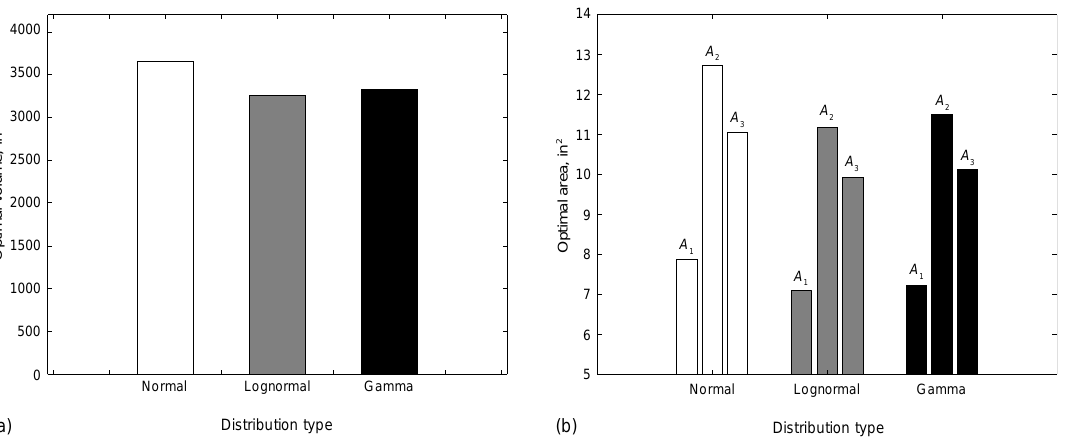
Figure 6. Results of the RBDO/CS – SORM-i framework for normal, lognormal, and gamma distribution cases. ( a ) Optimal volume, and ( b ) optimal areas.